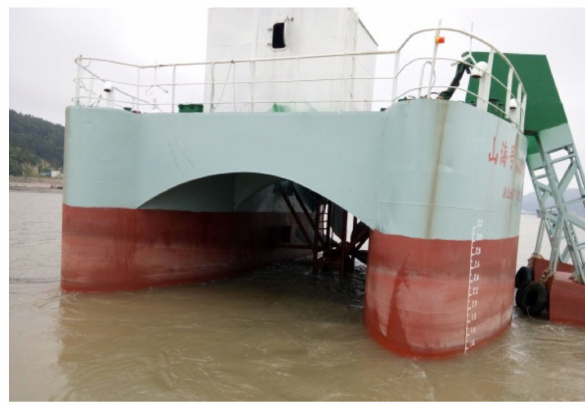
Figure 17. Ocean-energy power-generation platform.